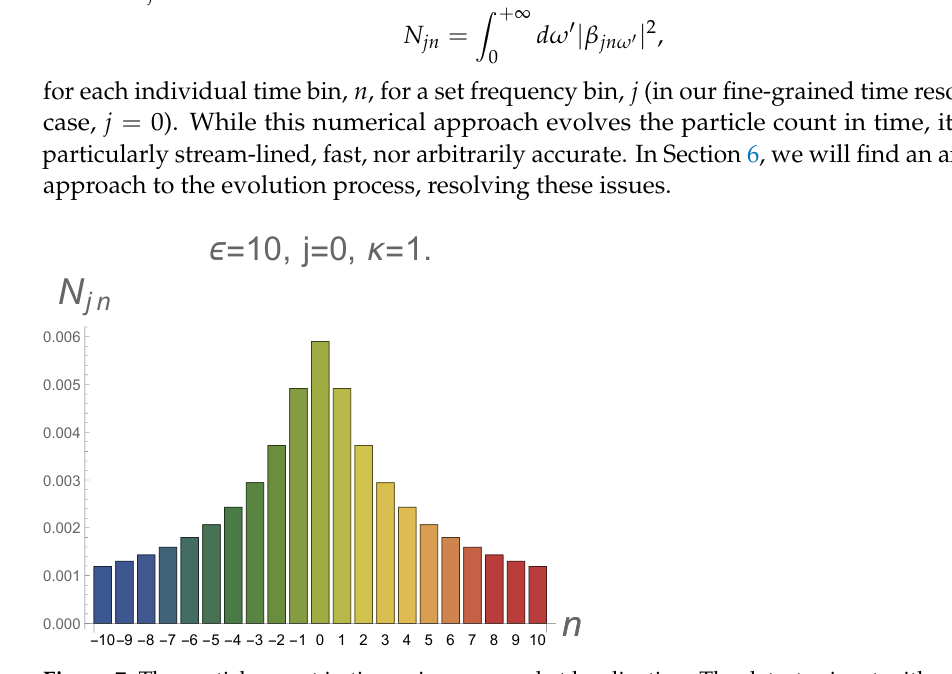
Figure 7. The particle count in time, via wave packet localization. The detector is set with (cid:101) = 10, a relative large value ( (cid:101) > 1) in order to get clear time resolution. The scale of the system is κ = 1 and the frequency bin is in the lowest possible j = 0 value, where most of the particle production occurs, and finer resolution in time is possible. Notice there is no plateau, hence indicative of non-thermal radiation. This emission includes the ‘phantom radiation’ of soft particles as described in [17]. It is symmetric in delayed time, u , centered around time bin n =